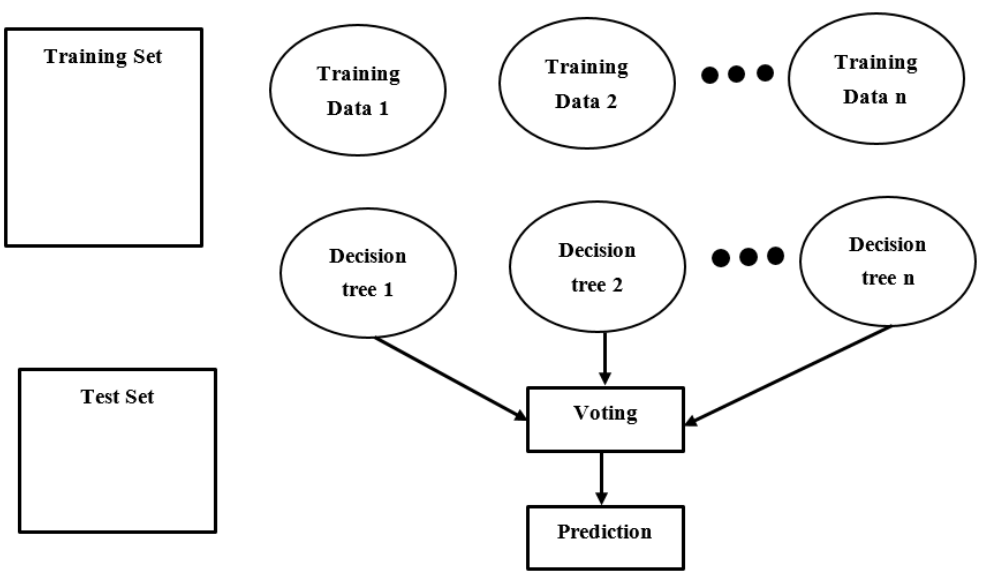
Figure 2. Working principle of random forest.